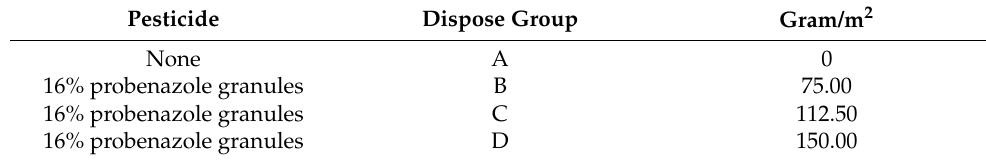
Table 2. Grouping of probenazole-treated rice seedlings inoculated with Magnaporthe grisea